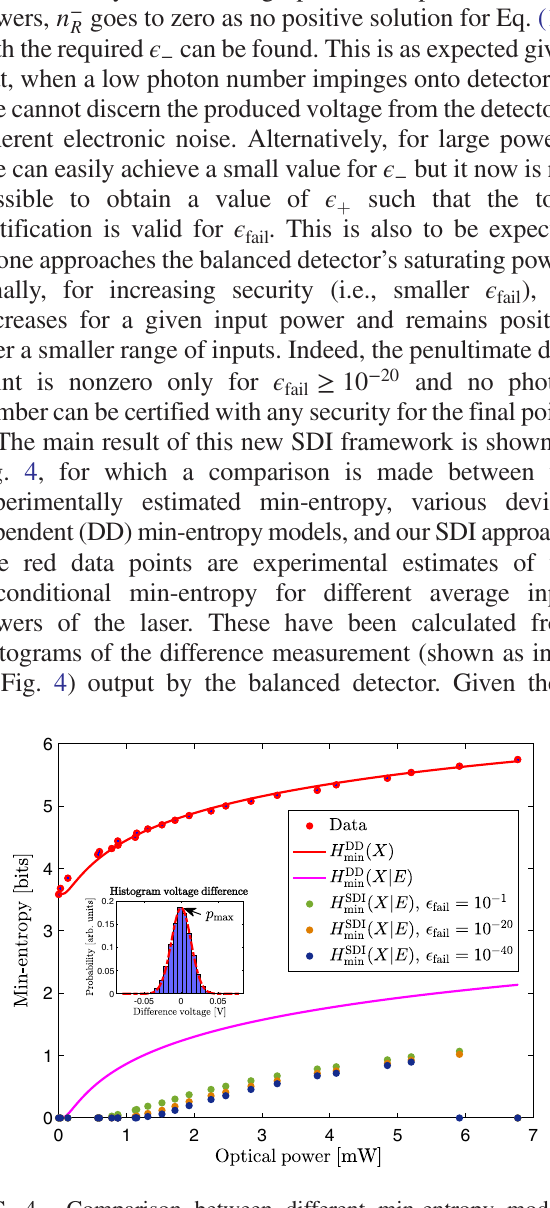
FIG. 4. Comparison between different min-entropy models. The red data points are the experimentally estimated min- entropies for different optical powers. These are obtained from the difference measurement ’ s voltage histograms shown in the inset (the voltage bins have been artificially thickened by a factor of 10 to make the figure comprehensible). Error bars for the data points have been included with the vertical component arising from the precision of the histogram ’ s Gaussian fit and the horizontal error showing the electronic noise ’ s contribution of detector C when measuring the optical power. H DD ð X Þ (red) and min H DD ð X j E Þ (pink) are the device-dependent (DD) min-entropy min models unconditioned and conditioned on Eve ’ s knowledge of in mode R R the noise. H SDI ð X j E Þ (green, orange and blue) are our SDI min estimations of the conditional min-entropy plotted against the input optical powers and for various security parameters ϵ fail